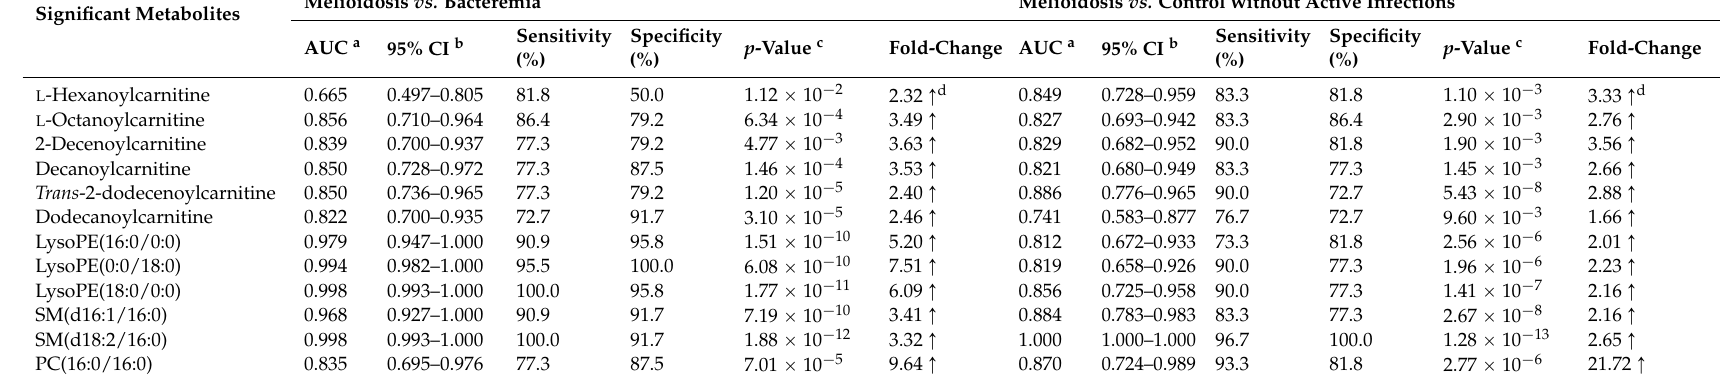
Table 2. The area-under-receiver operating characteristic curve (AUC), sensitivity and specificity for receiver operating characteristic (ROC) curves calculated at optimal cutoff as well as p -value and Fold-change for the twelve significant